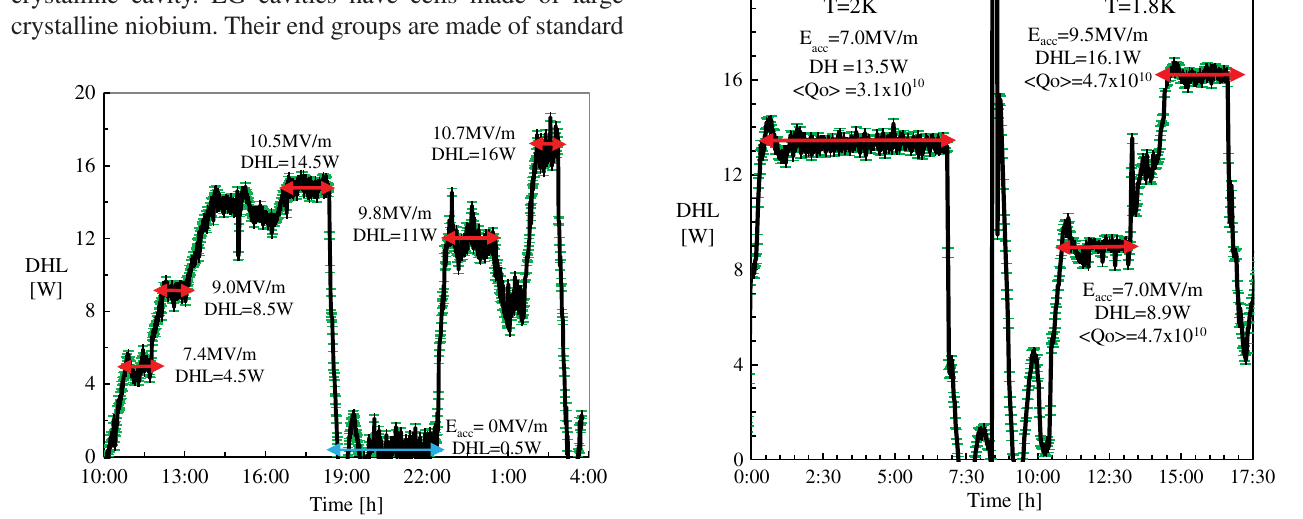
FIG. 9. DHL vs E 0 MV = m is marked in blue.